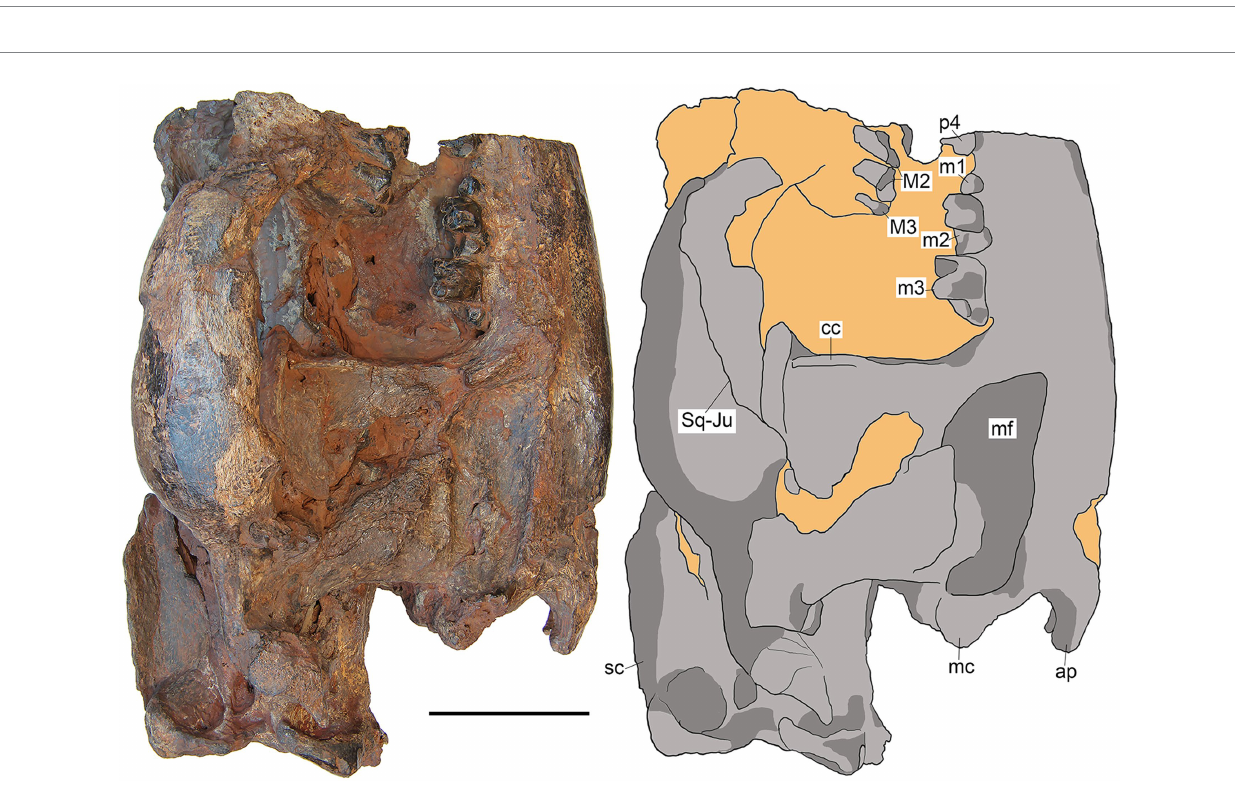
FIGURE 5 M. peregrinus , gen. et sp. nov., SYSU-M-5, holotype, a partial skull with associated mandibles in right lateral view (photograph and explanatory drawing). Youganwo Formation, upper Eocene, Maoming locality, Guangdong Province, China. ap, angular process; cc, coronoid crest; mc, mandibular condyle; mf, masseteric fossa; sc, sagittal crest; Sq-Ju, squamosal-jugal suture. Scale bar equals 5